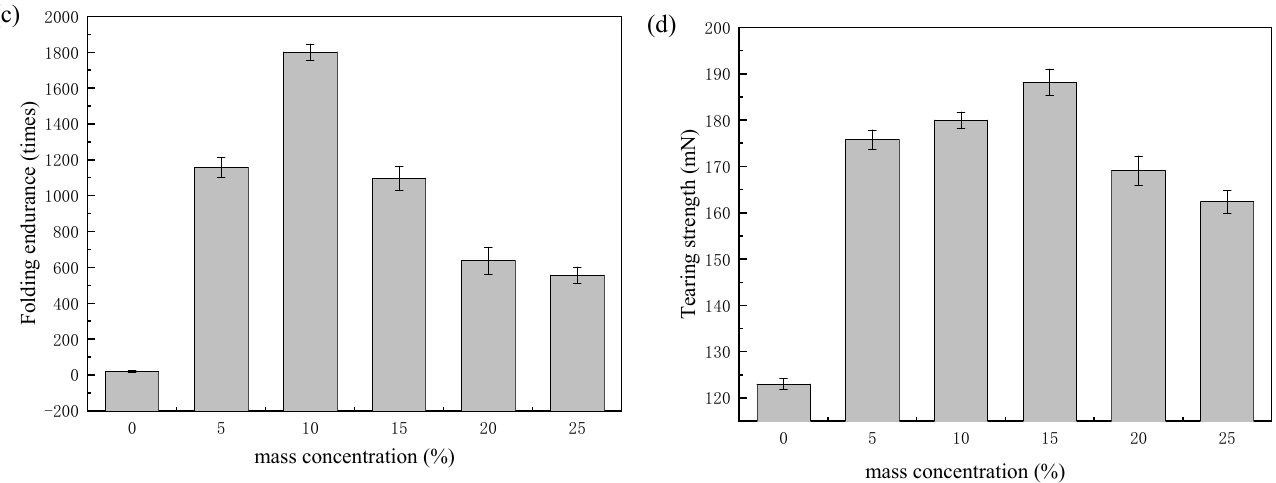
Figure 9. Mechanical properties of the paper treated with different mass concentrations of polyurethane: ( a ) tensile strength (the paper was cropped to a 24.0 cm × 1.5 cm size, tested at 20 mm/min); ( b ) elongation (the paper was cropped to a 24.0 cm × 1.5 cm size, tested at 20 mm/min); ( c ) folding endurance (the paper was cropped to a 15.0 cm × 1.5 cm size, tested at a force of 4.9N); ( d ) tearing strength (the paper was cropped to 6.5 cm × 5.0 cm).